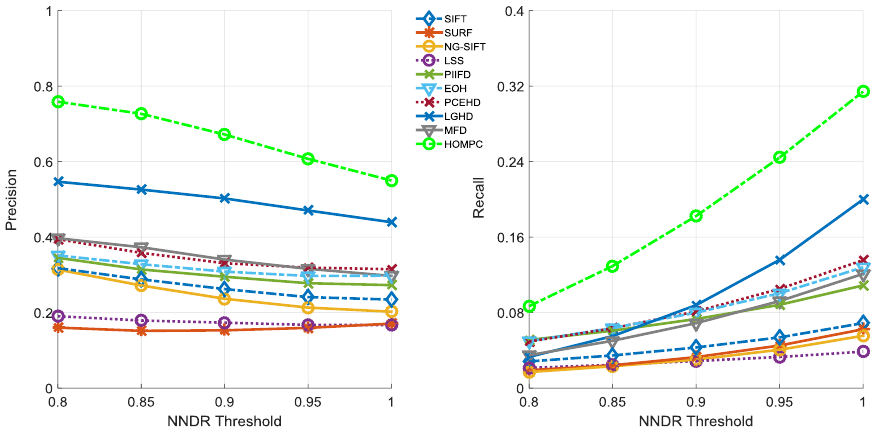
Figure 13. The average precision and recall curve results with different NNDR thresholds for all the descriptors. The HOMPC is our descriptor.